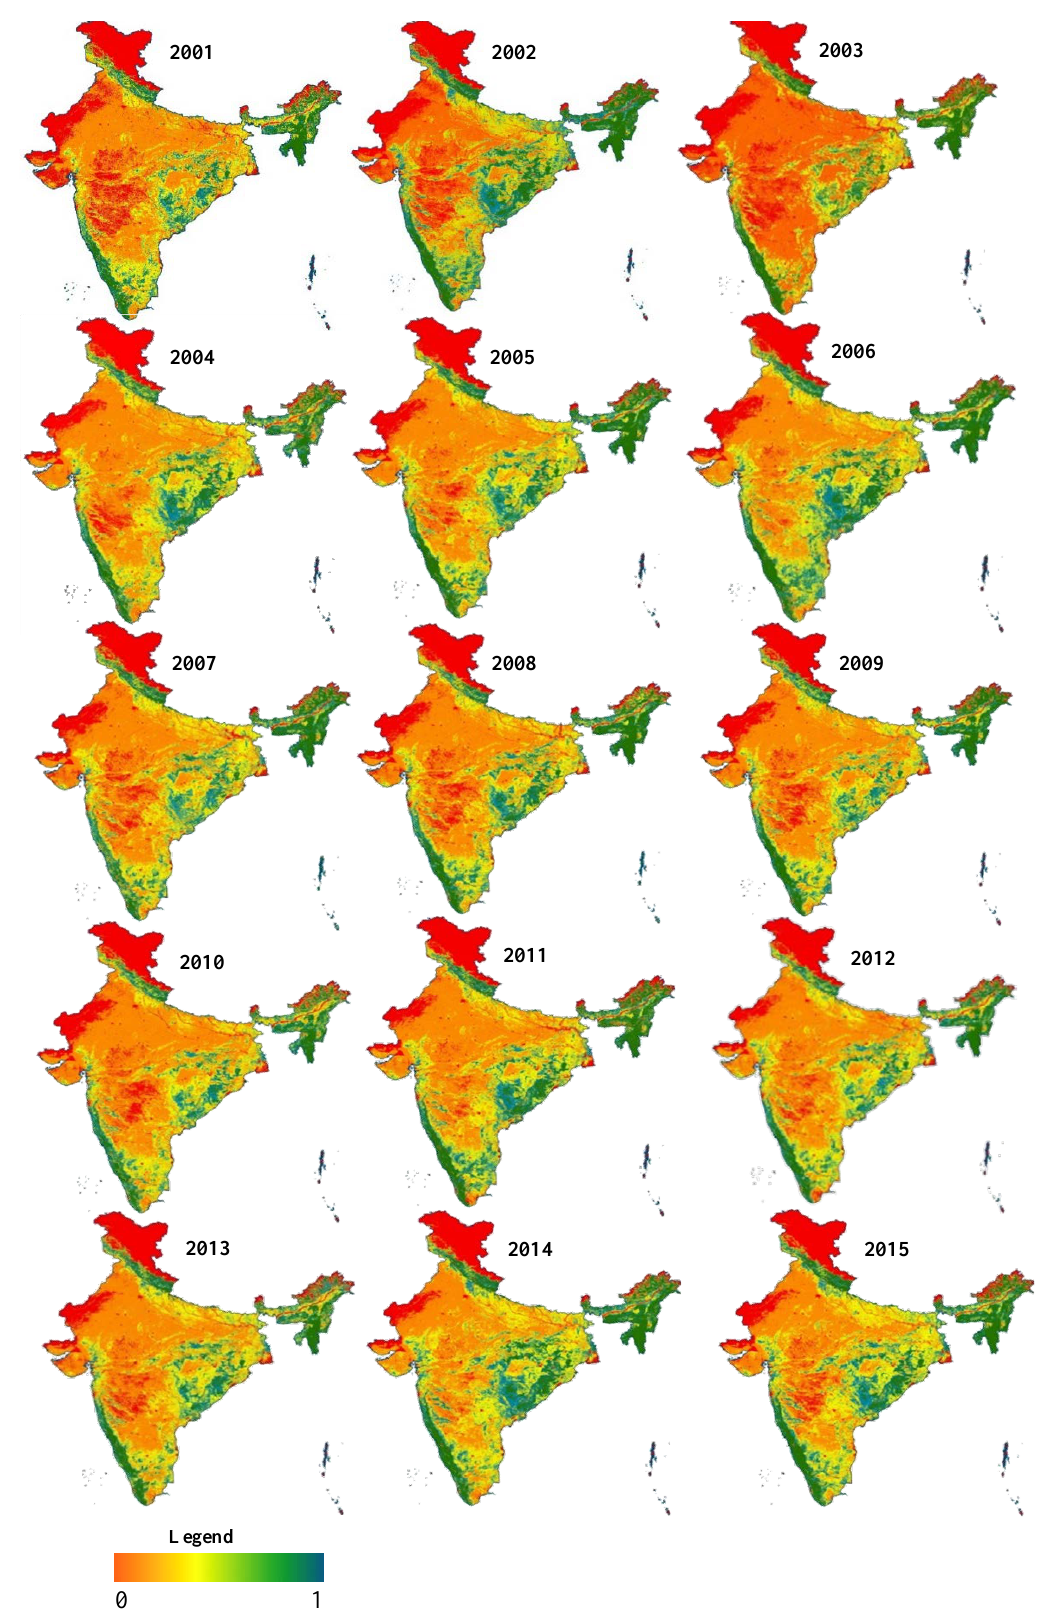
Figure 3. Minimum dynamic habitat index (DHI-min) represents the minimum monthly FAPAR value in a particular year and is utilized to map the variation of minimum greenness cover from 2001 to 2015 in